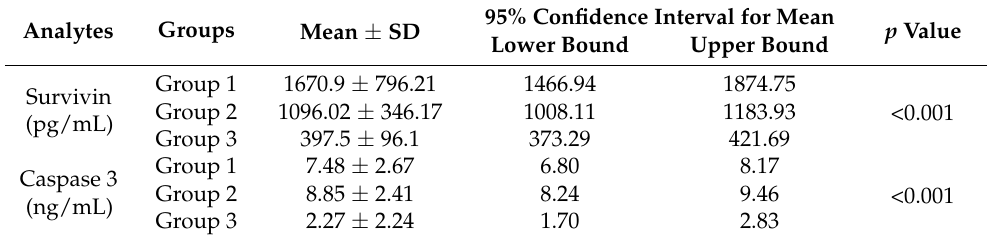
Table 1. Mean ± SD of the Survivin and Caspase 3 levels in the study